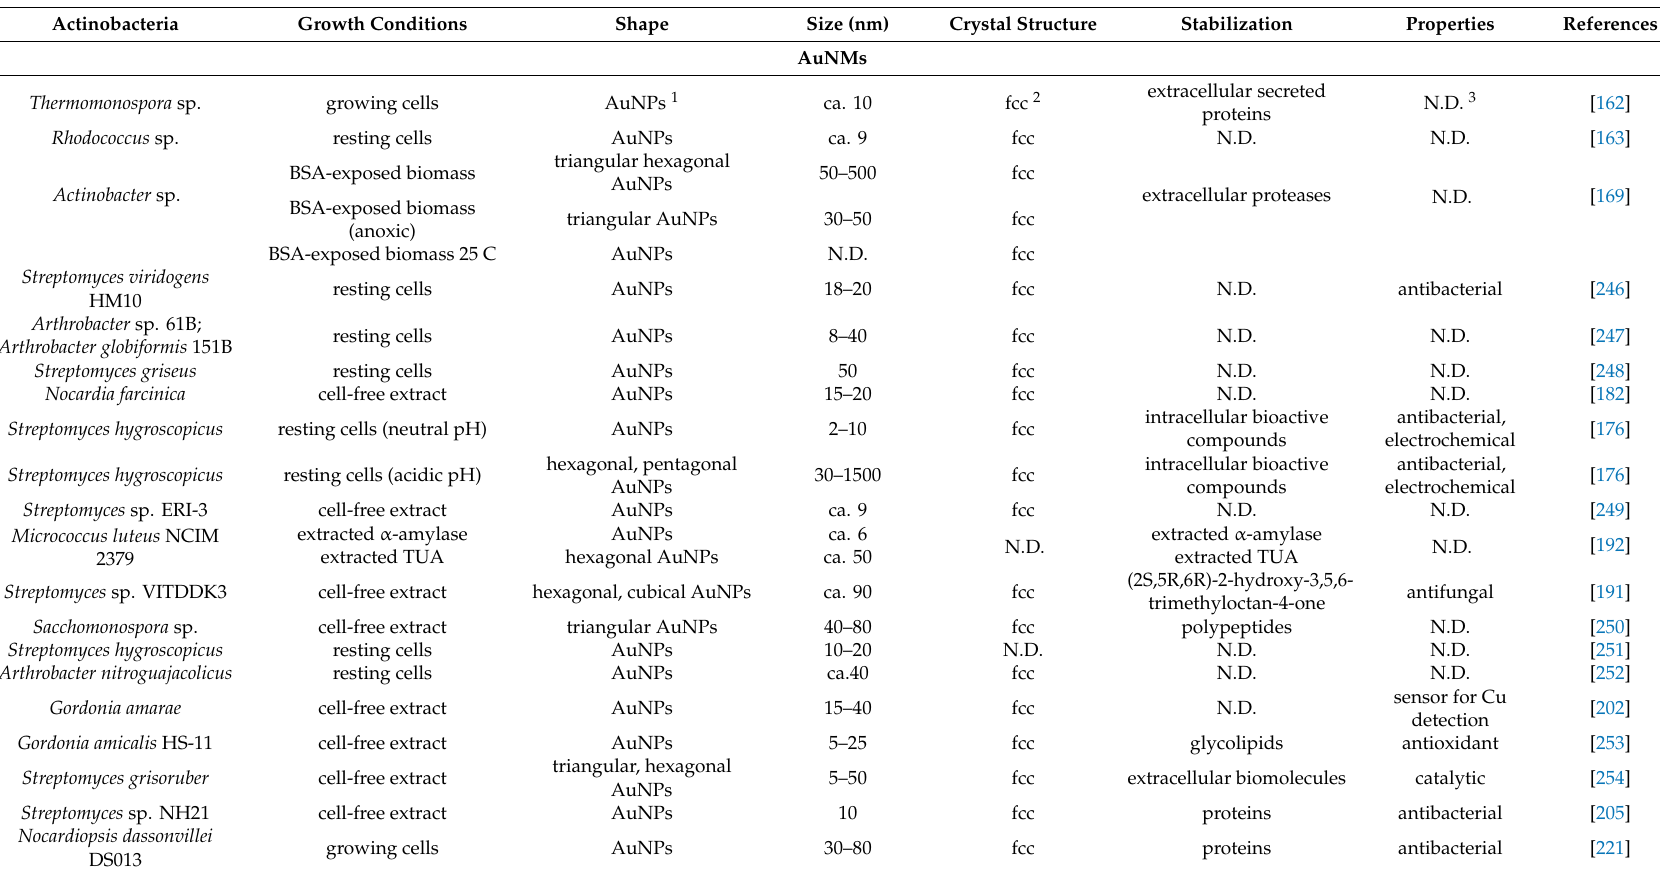
Table 4. Overview of metal(loid) NMs produced by Actinobacteria, their thermodynamic stabilization, physical-chemical and applicative properties.